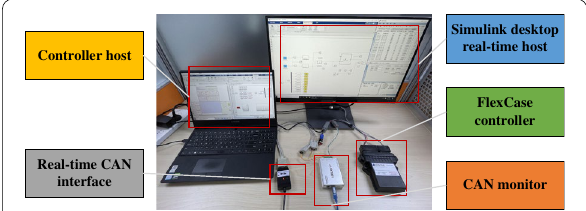
Figure 4 The hardware-in-the-loop experimental bench